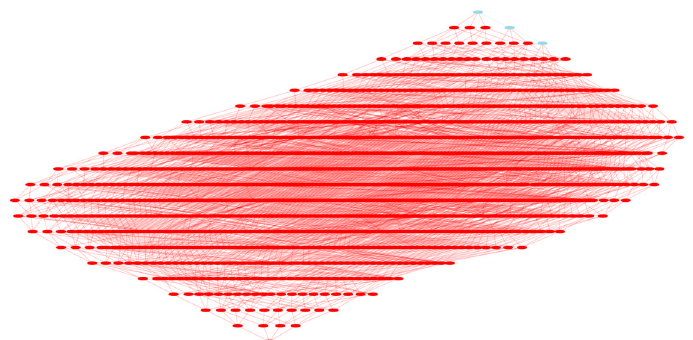
Figure 16. Solution Graph.